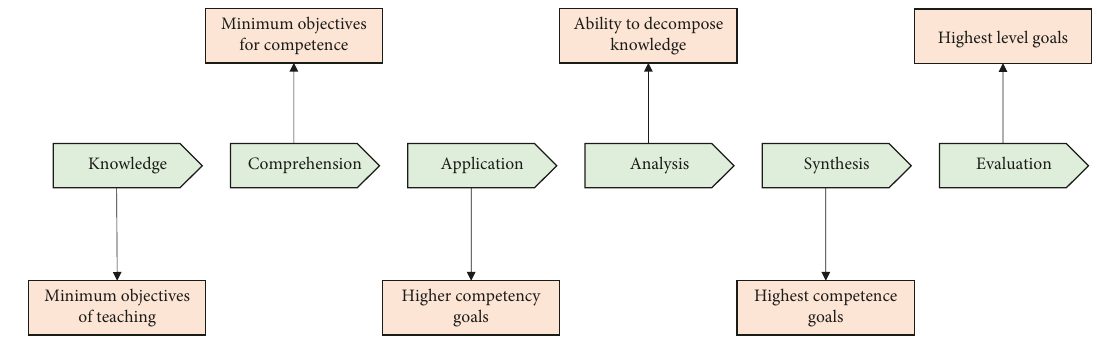
Figure 4: Cognitive domain teaching